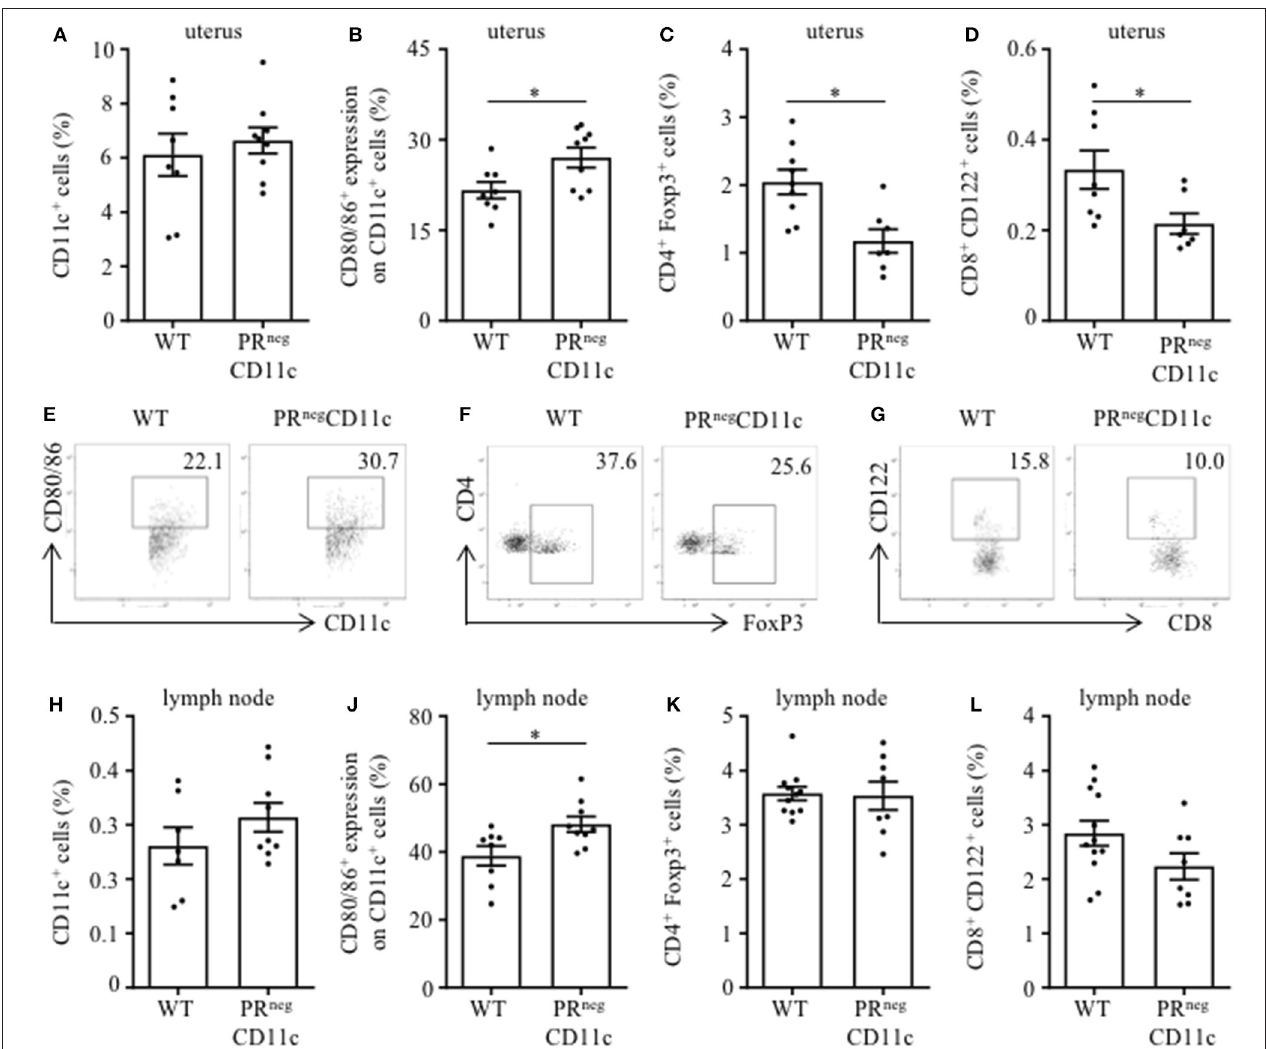
FIGURE 3 | Impaired progesterone-responsiveness of CD11c + dendritic cells (DCs) affects maternal immune adaptation: WT and PR neg CD11c female mice were allogenically mated and flow cytometric analysis was performed on gestation day 13.5. Graphs present the frequencies of (A) CD11c + DCs, (B) the co-expression of CD80 and CD86, (C) CD4 + FoxP3 + Treg cells, and (D) CD8 + CD122 + T cells in uteri harvested from WT and PR neg CD11c dams. Representative dot plots display CD80/86 expression on CD11c + cells (E) , FoxP3 + expression on CD4 + cells (F), and CD122 + expression in CD8 + T cells (G) of WT and PR neg CD11c mice. Respective cell frequencies in the right corner are expressed as percentage of CD11c + , CD4 + and CD8 + cells, respectively. (H–L) Flow cytometric analysis of CD11c + DCs (H) , the co-expression of CD80 and CD86 (J) , CD4 + FoxP3 + Treg cells (K), and CD8 + CD122 + T cells (L) in uterus-draining lymph node harvested from WT and PR neg CD11c dams. Bars represent mean ± SEM. * p ≤ 0.05, unless otherwise stated, cell frequencies are expressed as percentage of living CD45 +